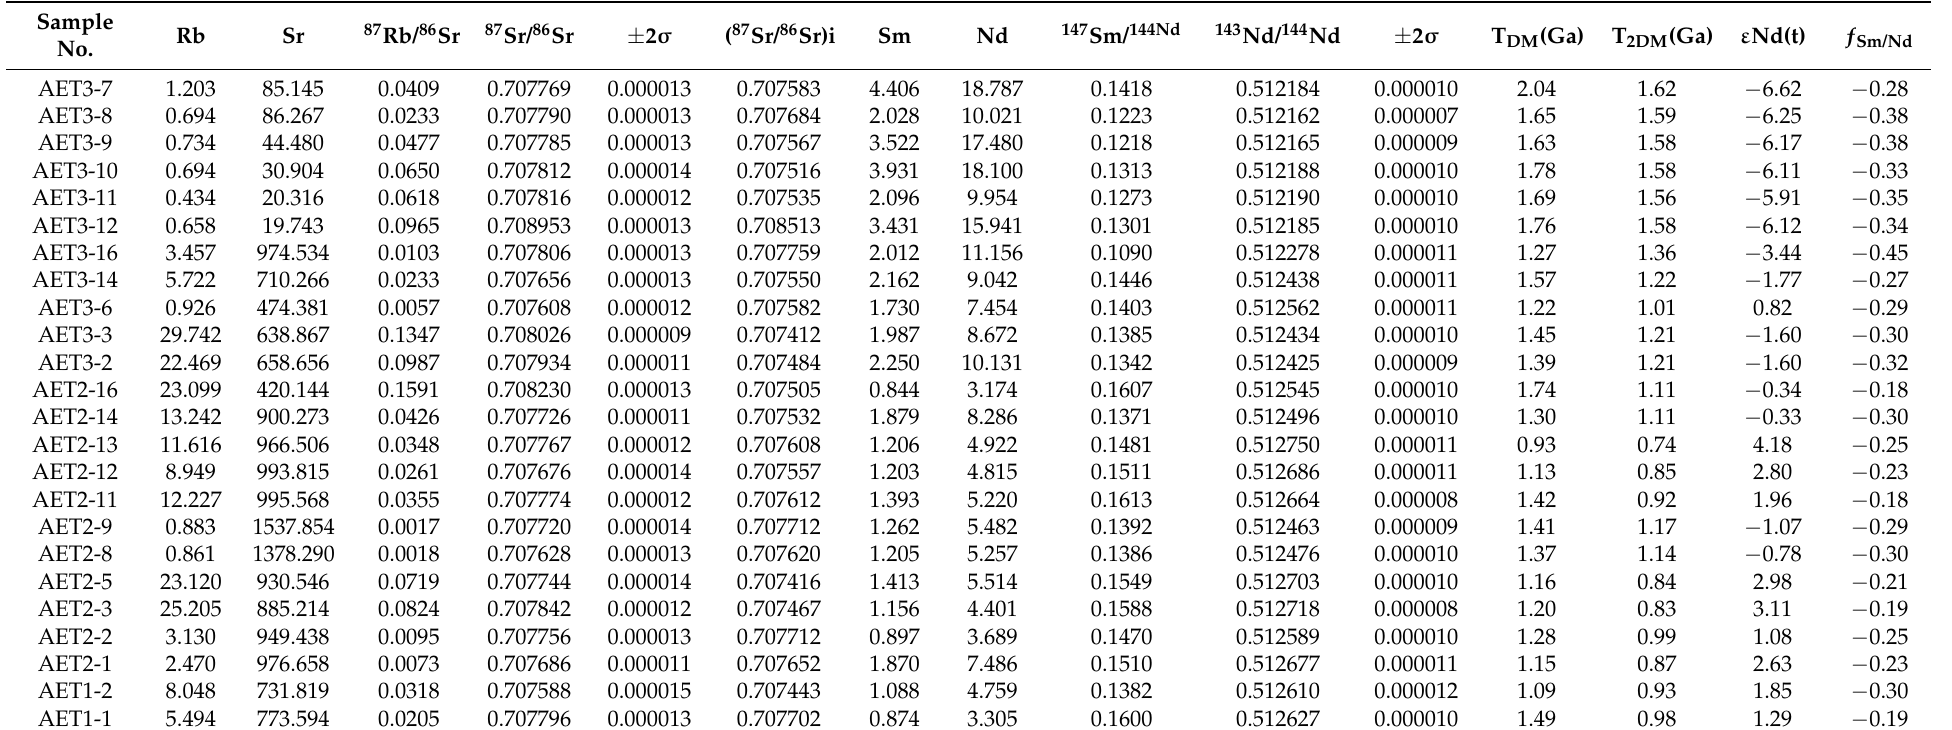
Table 2. Sr-Nd isotopic data of the Mn ores and associated wall rocks of the Upper Carboniferous Kalaatehe